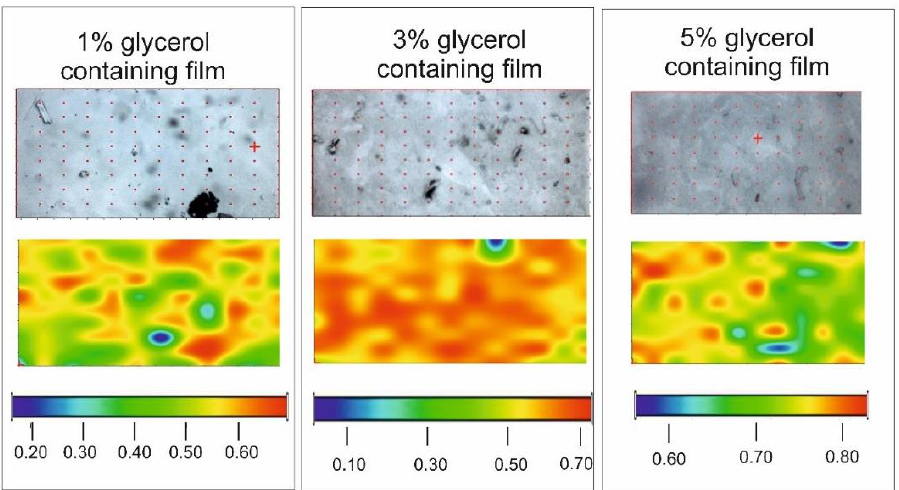
Figure 5. Chemical mapping of films with different GLY contents.